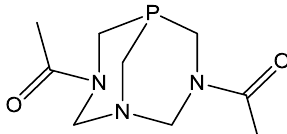
Figure 1. 3,7-diacetyl-1,3,7-triaza-5-phosphabicyclo[3.3.1]nonane (DAPTA).